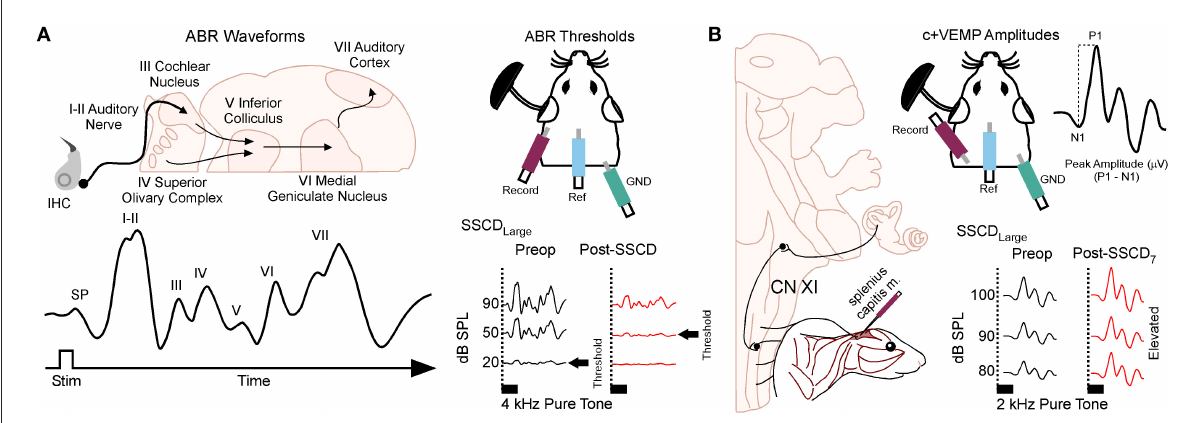
FIGURE2 Semicircular canal dehiscence induces sound-induced changes to auditory and vestibular physiology. (A) Cartoon showing the configuration for closed field auditory brainstem responses (ABR) and threshold shifts that occur for 2kHz tones after SSCD of the left ear. (B) Cartoon showing the configuration for the left ear when measuring the sound-induced cervical positive vestibular evoked myogenic potential (c + VEMP) in the anesthetized animal. Here, electrodes are inserted into the splenius capitus extensor muscles, and sound is delivered in a closed field to the ear with SSCD. The c + VEMP amplitude is calculated by subtracting the positive P wave 1 from the negative N wave 1. Pictured is the increase in c + VEMP amplitudes 7 days after surgical creation of a large SSCD.